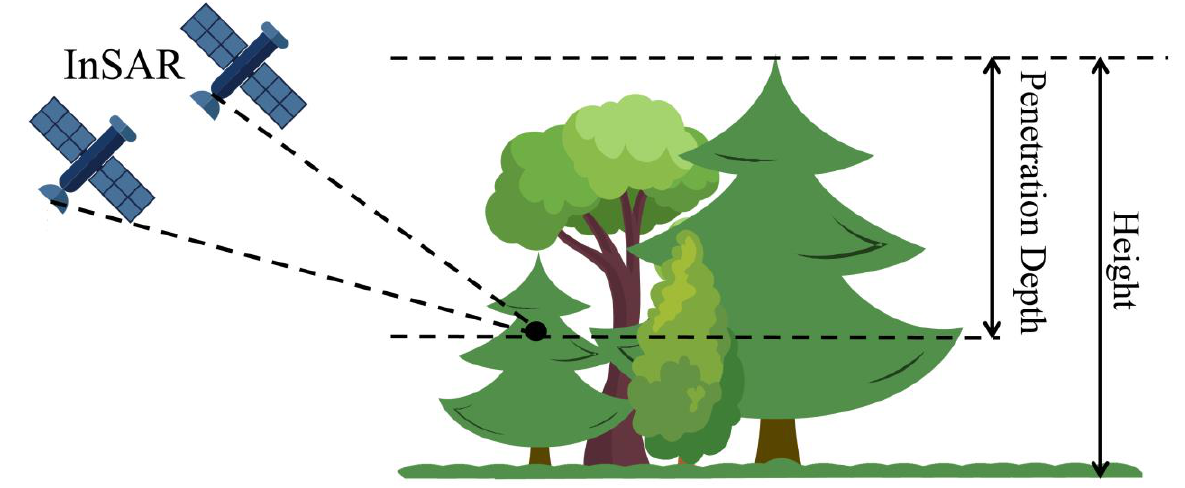
Figure 10. Schematic diagram of the penetration depth. All of the sample plots were pure coniferous forests with an equal distribution of trees and slight variation in the canopy height due to forests’ artificial nature. Therefore, in this study, we assumed that the normalized vertical structures of the trees in the forest were similar in a certain spatial domain and the SRTM DEM data was used to determine the transformed phase histogram to represent the vertical profiles of the trees in the region. vertical reflectance profile, and the Gaussian function was used for the profile fitting so as to represent the vertical structural change in the extinction coefficient with height (Figure